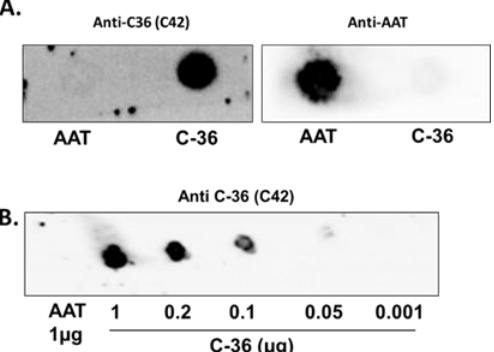
Figure 1. The specificity of the purified antibody (C42 mAb) tested by dot-blot analysis. ( A ). Full-length plasma purified alpha1-antitrypsin (AAT) (1µg) and C-36 peptide (1µg) or ( B ) various amounts of C-36 peptide were blotted onto the nitrocellulose membrane and the dot-blotted membranes were incubated with a mouse C42 mAb (1:500). In (A),